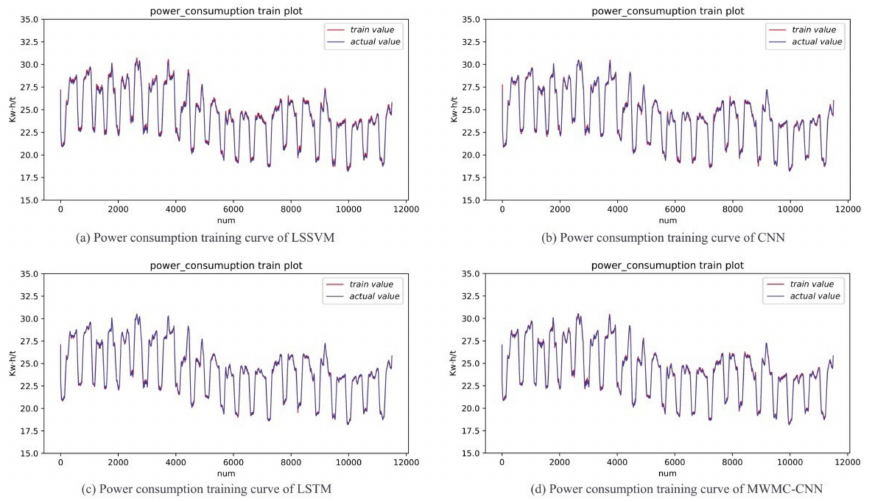
Figure 6. Electricity consumption training result curves of LSSVM, CNN, LSTM and MWMC-CNN.